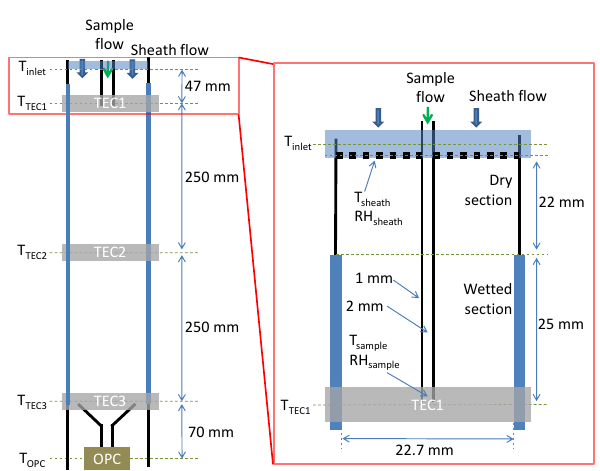
Fig. 1. CCN chamber dimensions and temperatures used in the